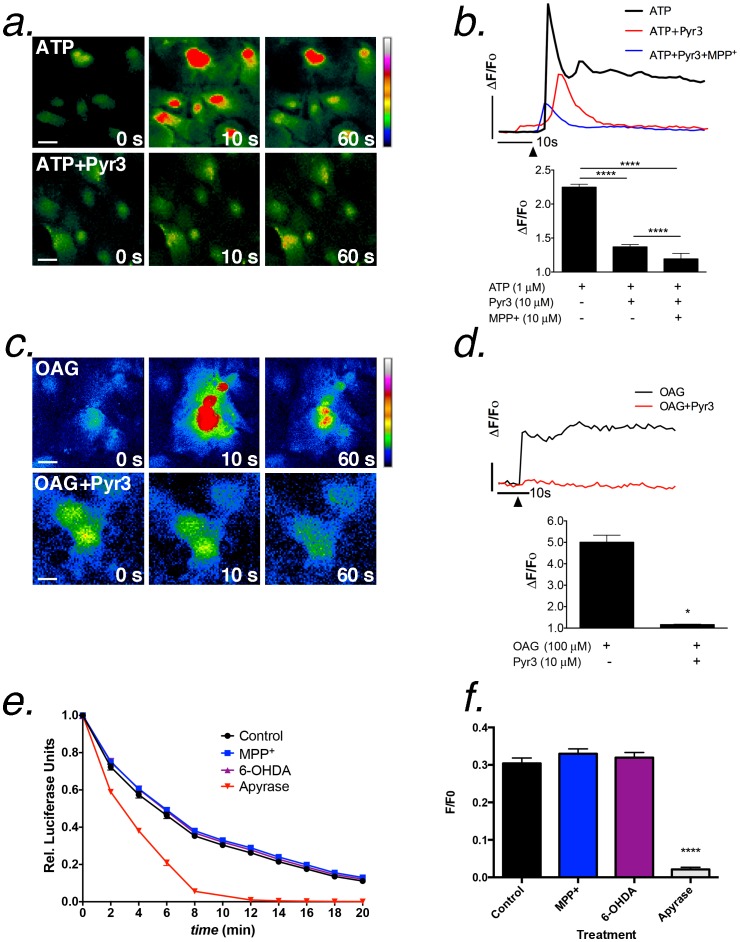
Inhibition of TRPC3 decreases ATP- and OAG-induced Ca2+ transients in striatal astrocytes.(a,b) Changes in Fluo-4 fluorescence in striatal astrocytes l following stimulation with 1 µM ATP in presence or absence of the TRPC3 inhibitor, pyrazole-3 (Pyr3; 10 µM). Prior treatment with Pyr3 for 30 minutes at 37°C decreased the Ca2+ response to ATP, whereas only a modest additive effect was observed with Pyr3 in the presence of 10 µM MPP+. (c,d) Addition of 100 µM OAG induced a rapid increase in Ca2+ that was abolished by pre-incubation with Pyr3. Vertical bars in (b and c) denote 1 relative fluorescent unit; the horizontal bars denote 10 sec. Black arrows indicate the time of stimulation with ATP or OAG. Representative images are shown at the start of imaging (time = 0 sec) and at the application of agonist (time = 10 sec) and again at time = 60 sec. Scale bar  =  10 microns. (e,f) Luciferase (40 ng/ml) was incubated with luciferin and ATP at 22°C for 20 min in the presence of MPP+ (10 µM) 6-OHDA (10 µM) or apyrase (5 U/ml). For imaging studies, n = 500–700 cells for each experiment over 2-3 independent experiments in separate cultures of striatal astrocytes; for luciferase experiments, n = 4 independent replicates. *p<0.05 relative to control, ** p<0.01 relative to control and treated groups, **** p<0.0001 compared to control, MPP+ and 6-OHDA.